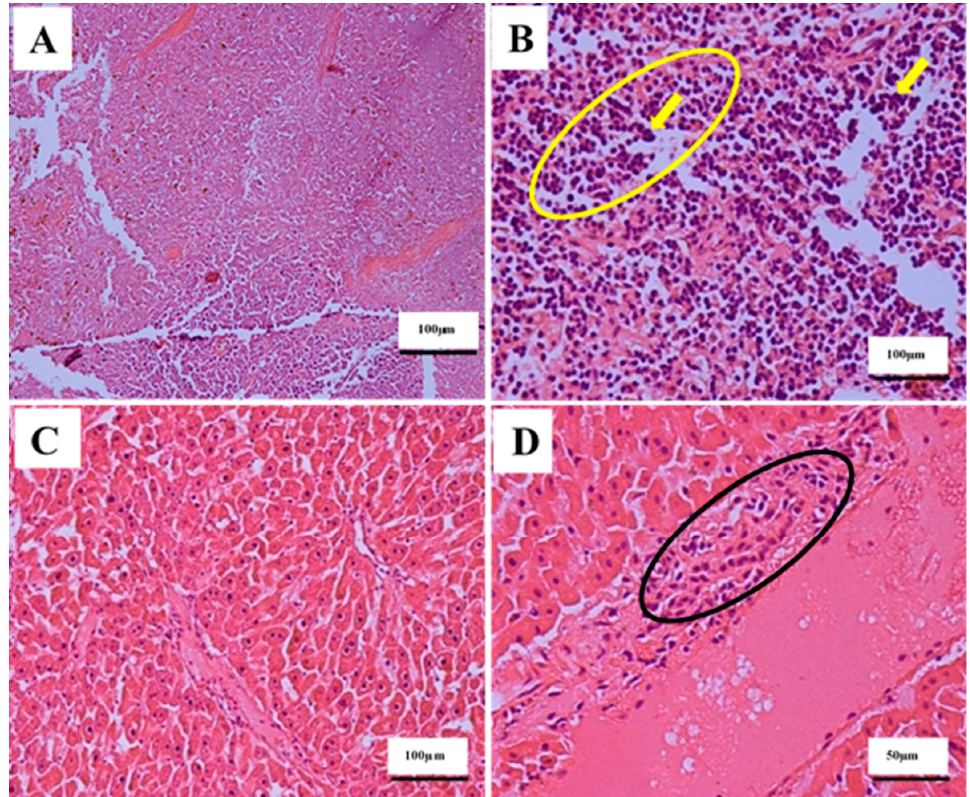
Figure 4. The effects of intraperitoneal (IP) injections of ENU on the histology of spleen and liver of ICR-mice, 12 weeks post injection. Key: ( A ) Photomicrograph of a spleen section (H&E stain ×200) from a mouse in control group showing normal histology of spleen. ( B ) Photomicrograph of a spleen section (H&E stain ×400) from a mouse in ENU treated group showing faded red pulp with numerous numbers of medium to large sized undifferentiated, bizarre pleomorphic nuclei (arrows) in the red pulp sinusoids and small focal aggregates in the splenic parenchyma (yellow encircled). ( C ) Photomicrograph of a liver section (H&E stain ×200) from a mouse in control group showing normal histology of liver. ( D ) Photomicrograph of a liver section (H&E stain ×400) from a mouse in ENU treated group showing metastasis of numerous numbers of medium to large size neoplastic lymphocytes to the liver (black encircled). Scale bars are indicated at the respective images. ENU = n- ethyl- n- nitrosourea, H&E = haematoxylin and eosin.